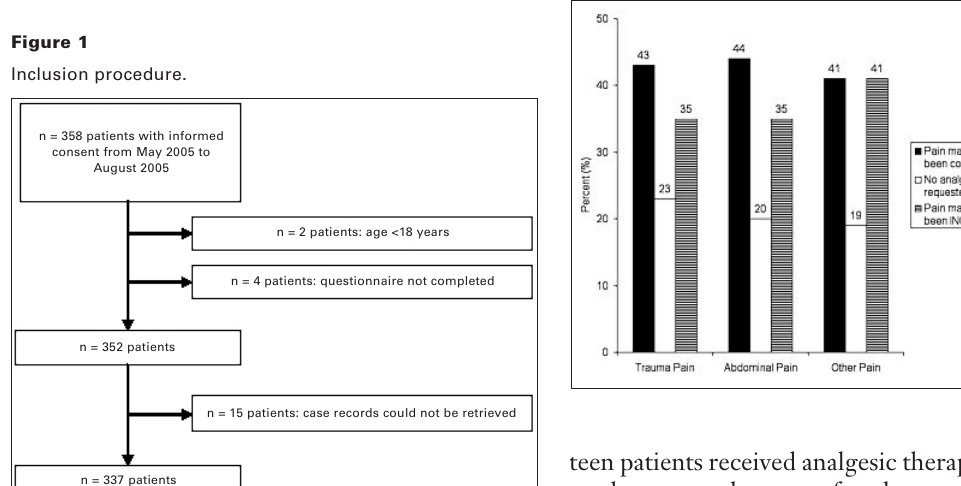
Adherence to pain management protocols during course of therapy